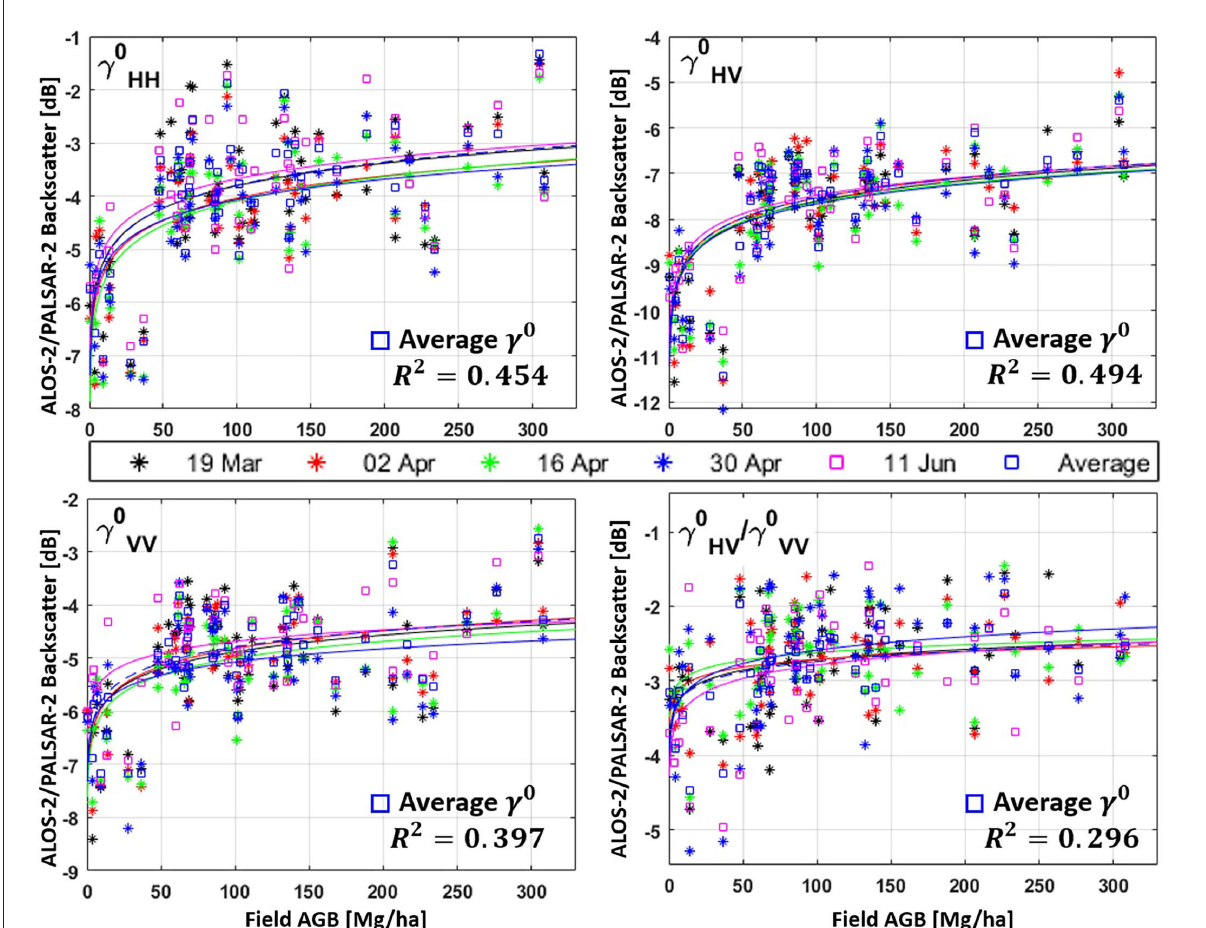
FIGURE5 Gamma nought γ 0 backscatter for HH, HV, VV, and HV/VV backscatter ratio plotted (in dB) as a function of field measured AGB (Mg/ha). The running average trend is also plotted to simplify the analysis. Different colors correspond to the five ALOS-2/PALSAR-2 acquisitions and one temporal average backscatter. The coefficient of determination R 2 for the temporal average bacskcatter plot is also